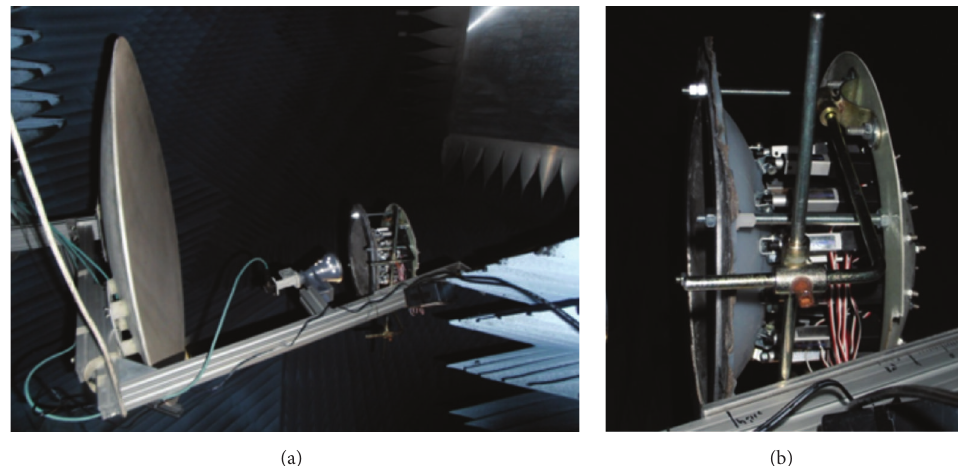
Figure 5: The dual-reflector antenna with the dynamic subreflector. (a) The overall system during an RF test. (b) The flexible subreflector.